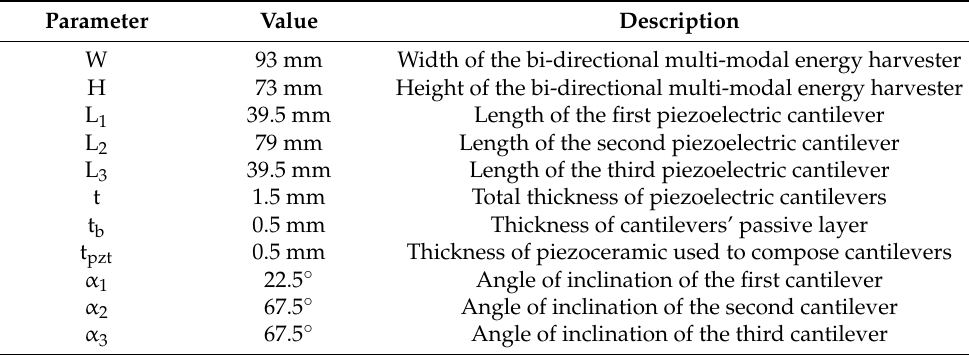
Figure 1. Sketch of bi-directional multi-modal piezoelectric energy harvester; 1—clamping base; 2—clamping plate of harvester; 3—clamping bolts of harvester; 4—6 piezoelectric cantilevers; M1–M4 seismic masses. Table 1. Geometrical parameters of bi-directional multi-modal energy harvester.